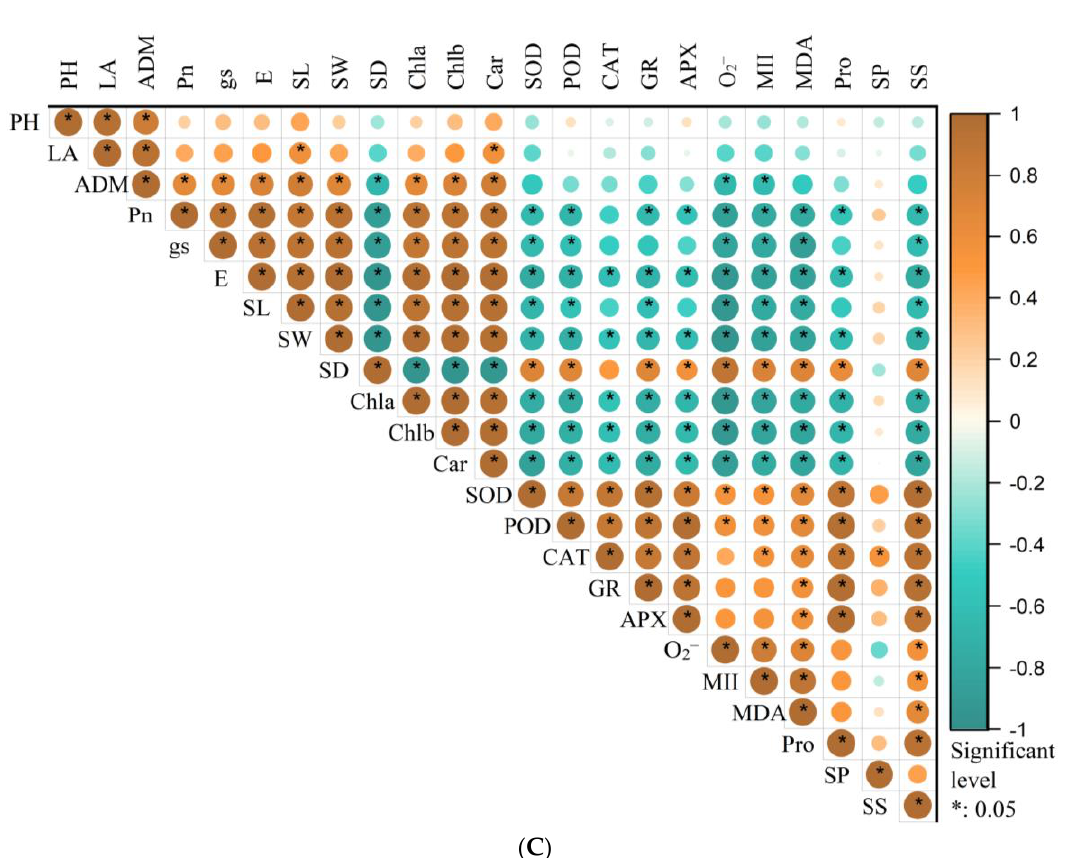
Figure 8. ( A ) Heatmap analysis of physiological traits. ( B ) Principal component analysis of physio- logical traits. ( C ) The relationships between growth and physiological traits.